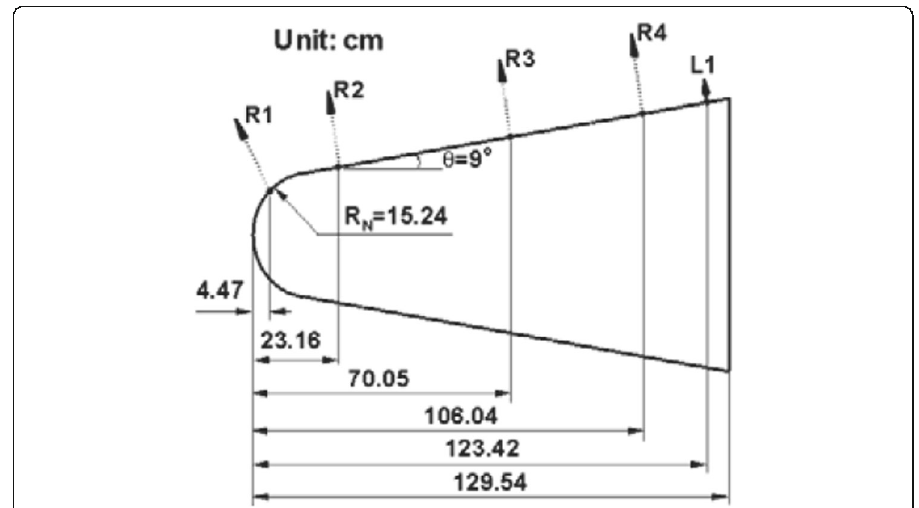
Fig. 5 RAM-C II configuration and probe distribution